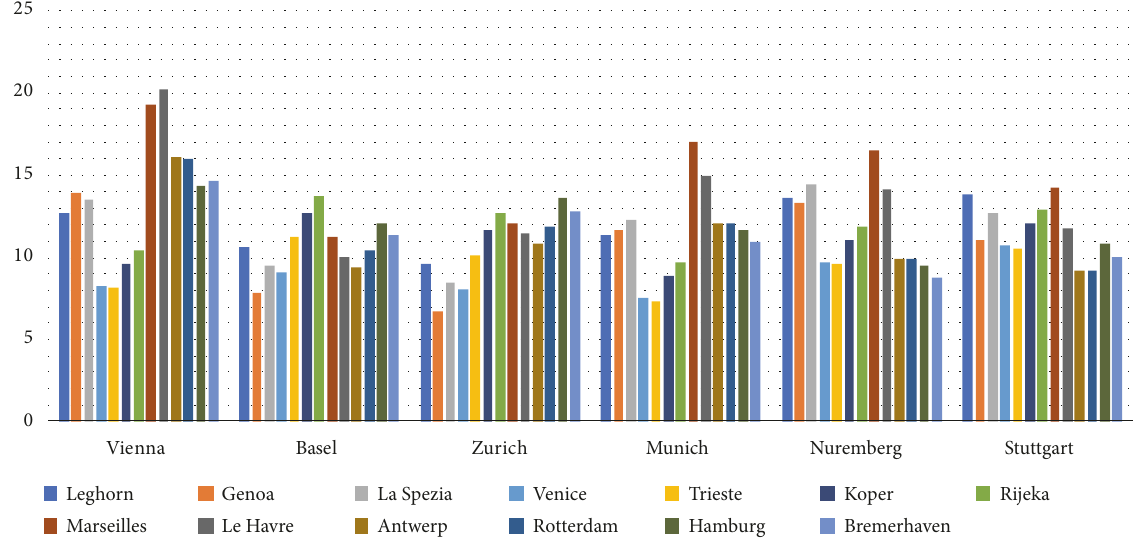
Figure 6: Traveltimes (h) from the ports considered in the analysis, towards Central-SouthernEuropean destinations. Optimisation by travel